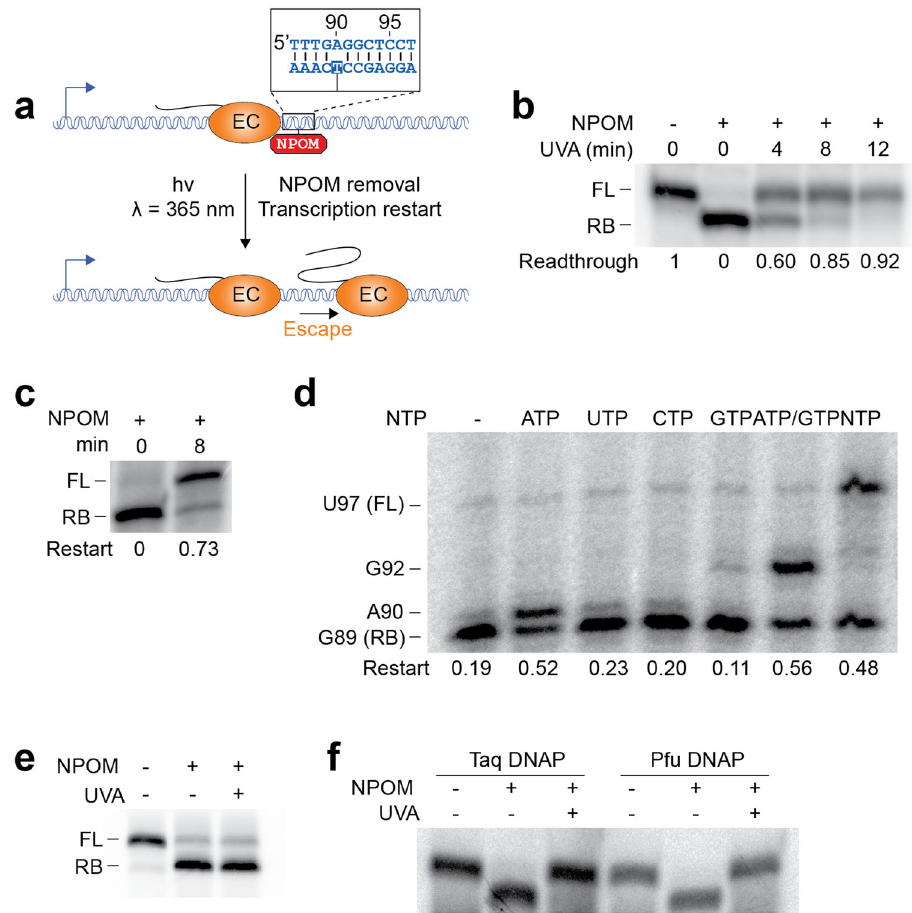
Fig. 3 NPOM removal allows transcription elongation to resume. a Transcriptional roadblocking by NPOM, followed by transcription restart upon UV irradiation. b NPOM-caged DNA templates were subjected to UV light ( λ = 365 nm) for increasing amounts of time, before transcription. c NPOM- roadblocked ECs were subjected to UV light with NTPs still present in the reaction mixture. Production of the full-length transcript indicates that transcription resumes after NPOM cleavage. d NPOM-roadblocked templates were puri fi ed on a G50 column and water ( − ) or ATP, UTP, CTP, GTP, ATP, and GTP or NTPs (50 µ M) were added before ultraviolet irradiation. Transcription resumes after the addition of ATP, but not UTP, CTP, or GTP. When ATP was present (A, AG, and NTP), ultraviolet exposition allowed transcription to resume up to positions A90, G92, and U97, respectively. e NPOM ef fi ciently blocks transcription by the T7 RNAP, but does not allow restart upon UV irradiation. Transcription was performed using a template containing the T7 promoter, and a GCG upstream of the 5 ′ GUU. f NPOM ef fi ciently blocks replication by the Taq and Pfu DNAPs. NPOM cleavage by UV irradiation